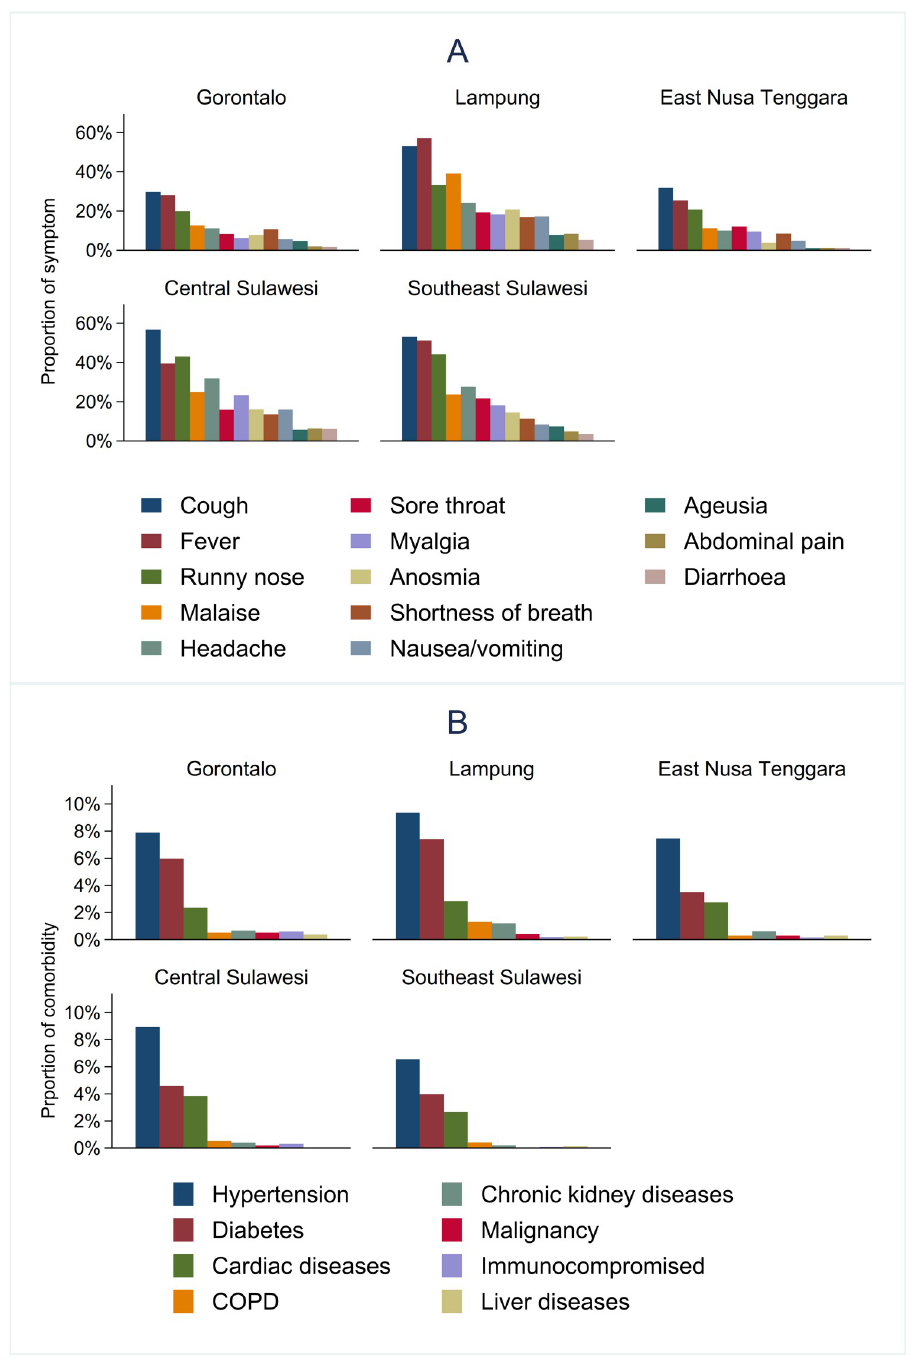
Fig 3. Presenting symptoms (A) and comorbidity (B) among symptomatic cases in 5 provinces in Indonesia. https://doi.org/10.1371/journal.pone.0283805.g003 reporting data from rural settings of Indonesia. The observed disease pattern broadly reflects that reported globally, with patients usually presenting multiple symptoms of fever, cough, malaise and/or shortness of breath. The overall mortality and hospitalisation rate was 3.1% (205/6,583) and 26.2% (1,727/6,583), respectively. The age-specific mortality and